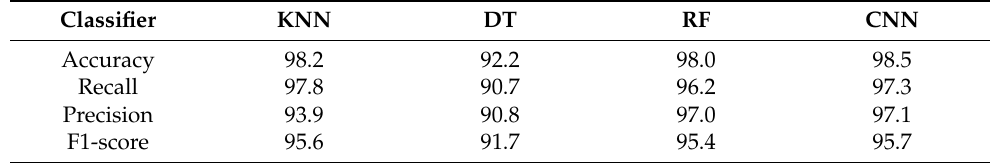
Table 6. Phase 2: Anomaly detection results in Scenario A: single mouse movement action.